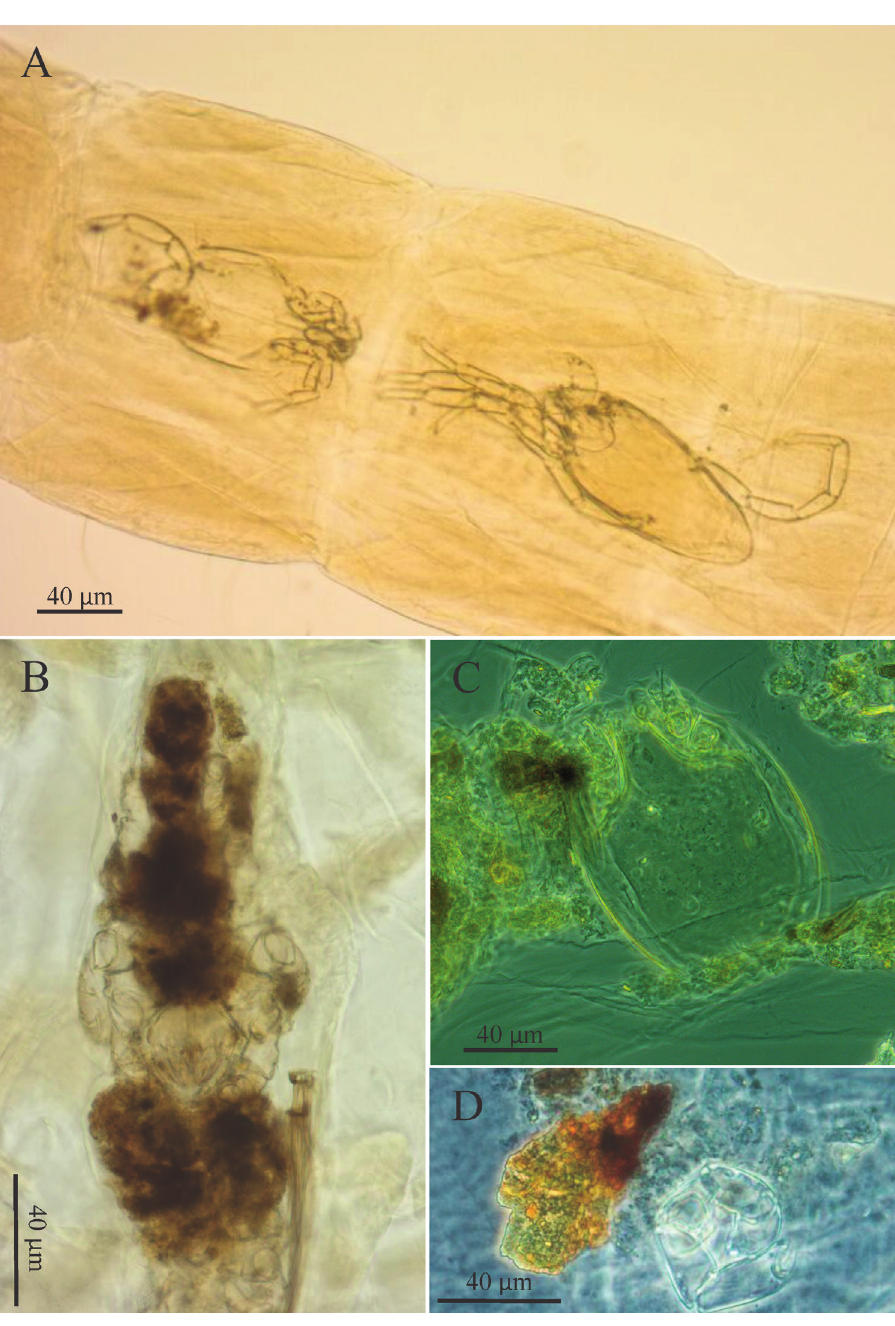
Figure 2. Mites found in gut contents of four specimens of Tanypodinae (Chironomidae). A Two ex- amples of Limnesiidae larvae (Acariformes: Trombidiformes), probably belonging to the genus Limnesia B–D partially digested mites, probably